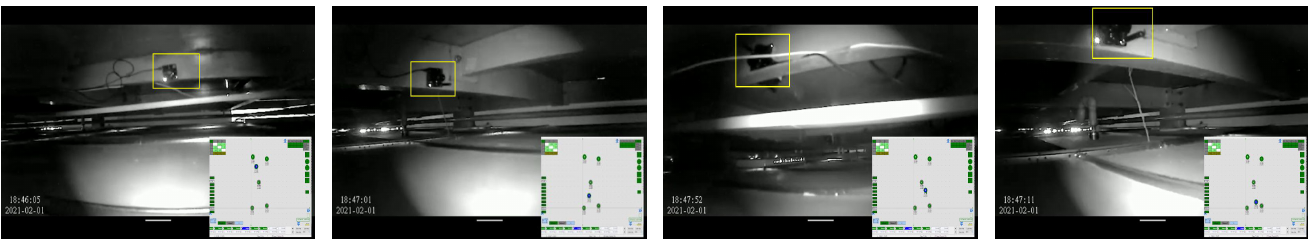
Figure 11. UWB beacon placement in the SUTD false ceilings and tracking results.